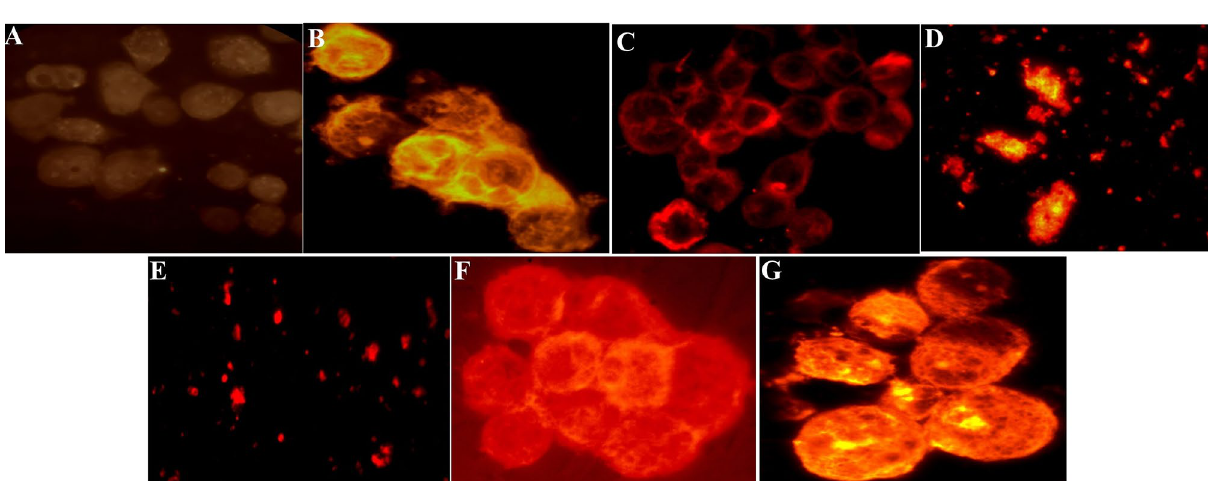
Figure 5. HT-29 CRC cell death detection by TUNEL assay after 48hrs. Apoptotic cells presented their morphology by taking up a fluorescent dye. ( A ) control. ( B ) cells treated with Na 2 S (IC 50 : 5 mM). ( C ) Cells treated with SNP (IC 50 . 10 −6 M). ( D ) Cells treated with 5-FU (11.25 µM after five days). ( E ) Cells treated with the combination of 5-FU and Na 2 S. ( F ) Cells treated with the combination of 5-FU and SNP.G. Cells with a triple combination of 5-FU, Na 2 S, and SNP (images at 1000 ×